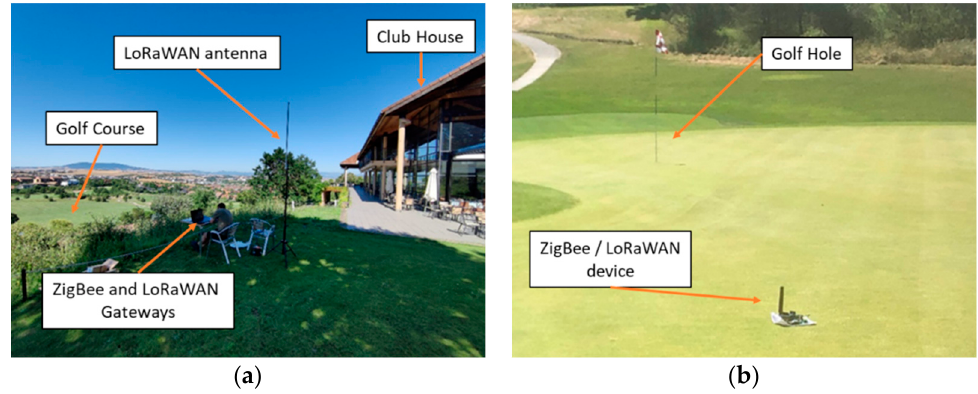
Figure 12. ( a ) Gateways deployment in front of the Club House; ( b ) Node deployment on the